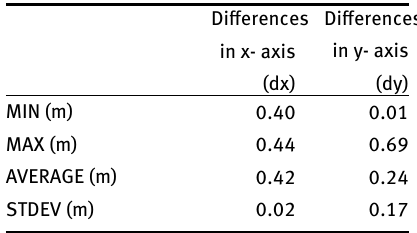
Figure 2: Distribution of the fingerprint data points and Zigbee test results Table 1: Summary of positioning errors